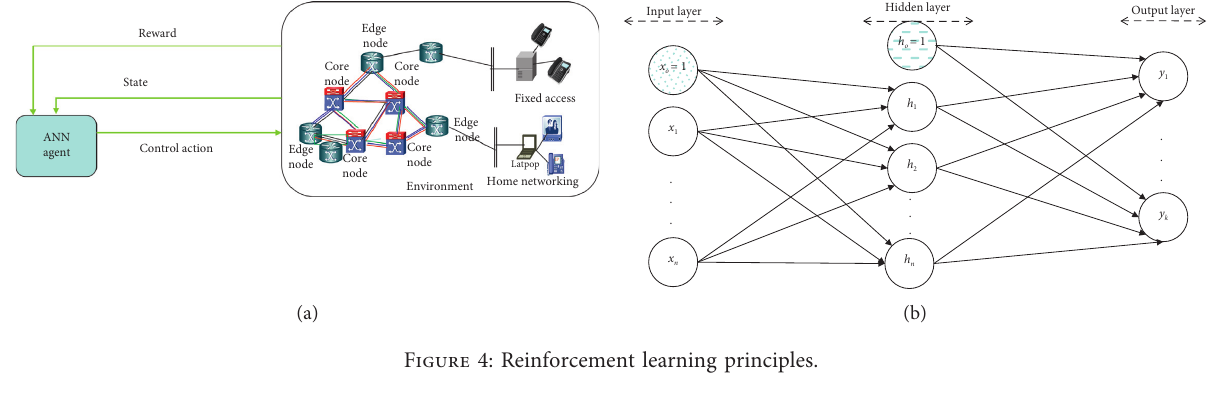
Figure 4: Reinforcement learning